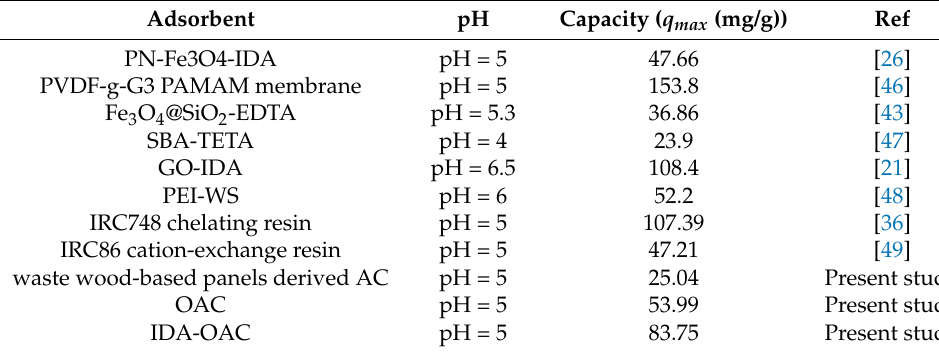
Table 4. Comparison of studies on copper ion